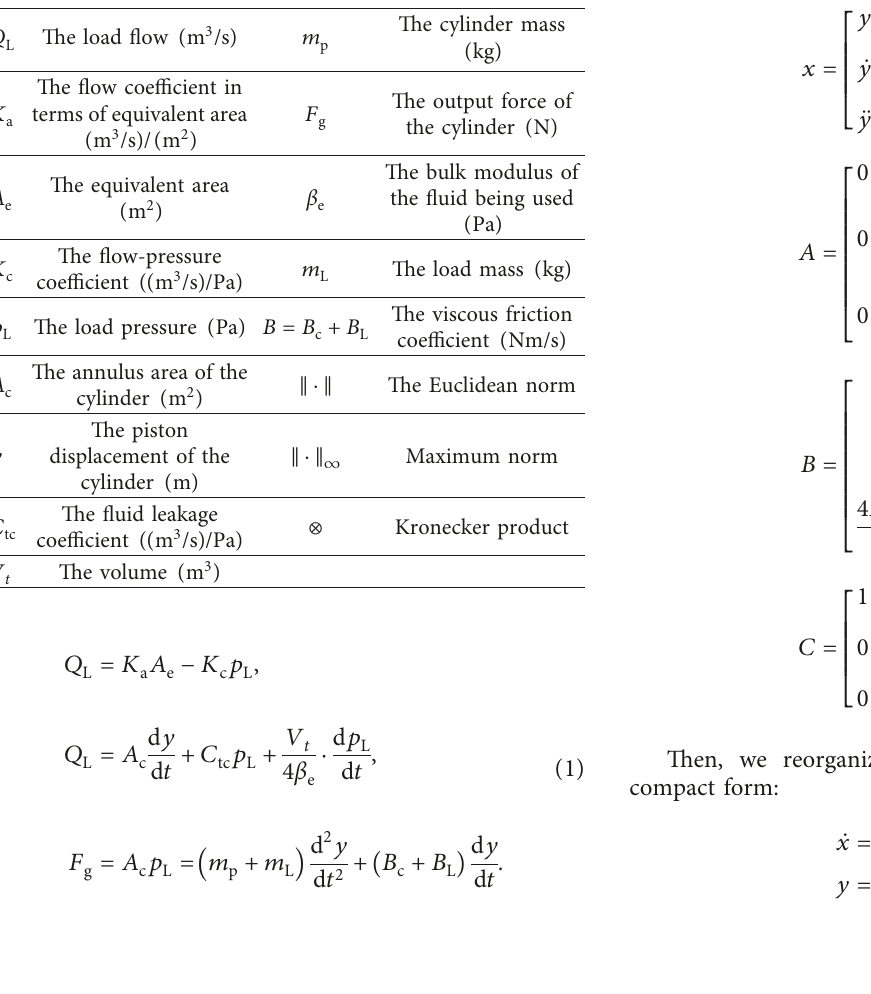
Figure 1: The scheme of designed intelligent hydraulic lifting system. Table 1: